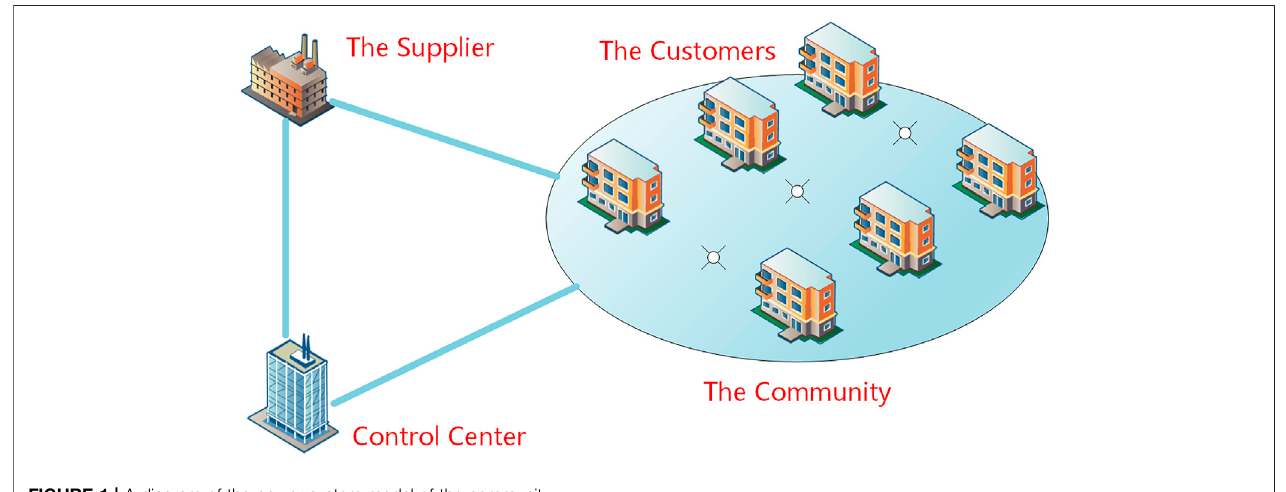
FIGURE 1 | A diagram of the power system model of the